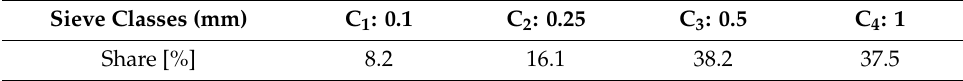
Table 1. Standardized particle size distribution of samples.